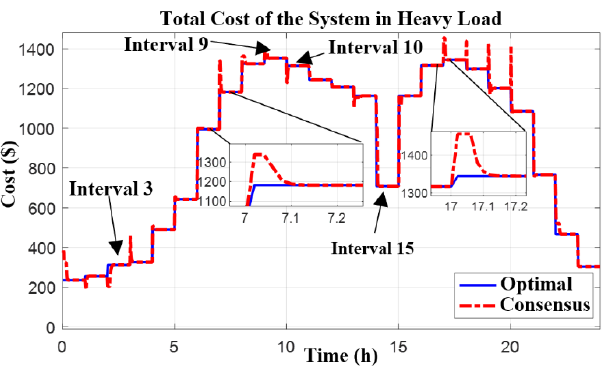
Figure 9. The total cost of the system under the light-load scenario.